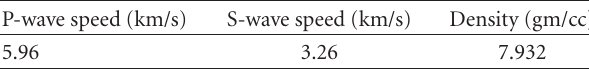
Table 2: Acoustic properties of steel.